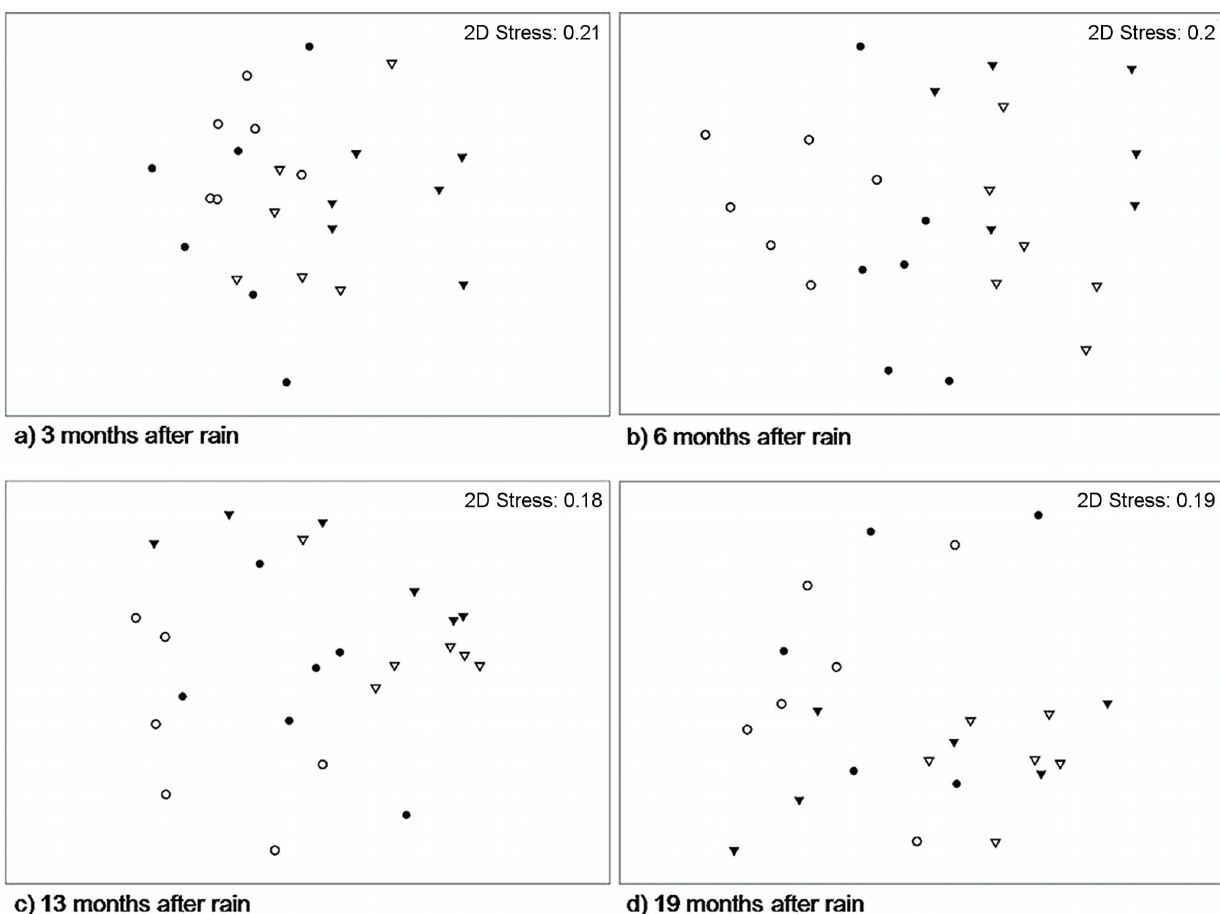
Figure 3. nMDS ordination plots showing differences in vegetation species assemblages under different grazing regimes. a) 3 months, b) 6 months, c) 13 months and d) 19 months after above average rainfall in early 2007. Data were fourth-root transformed and a zero- adjusted Bray-Curtis similarity matrix was used. Grazing intensity is indicated by shape (‘light’=circle, ‘heavy’=triangle) and grazing treatment is represented by fill shading (‘ + cattle’=open, white), ‘ 2 cattle’=closed, black). For each of the four treatment groups there were three vegetation samples taken on each of the two replicate grids for a total of six samples per treatment.